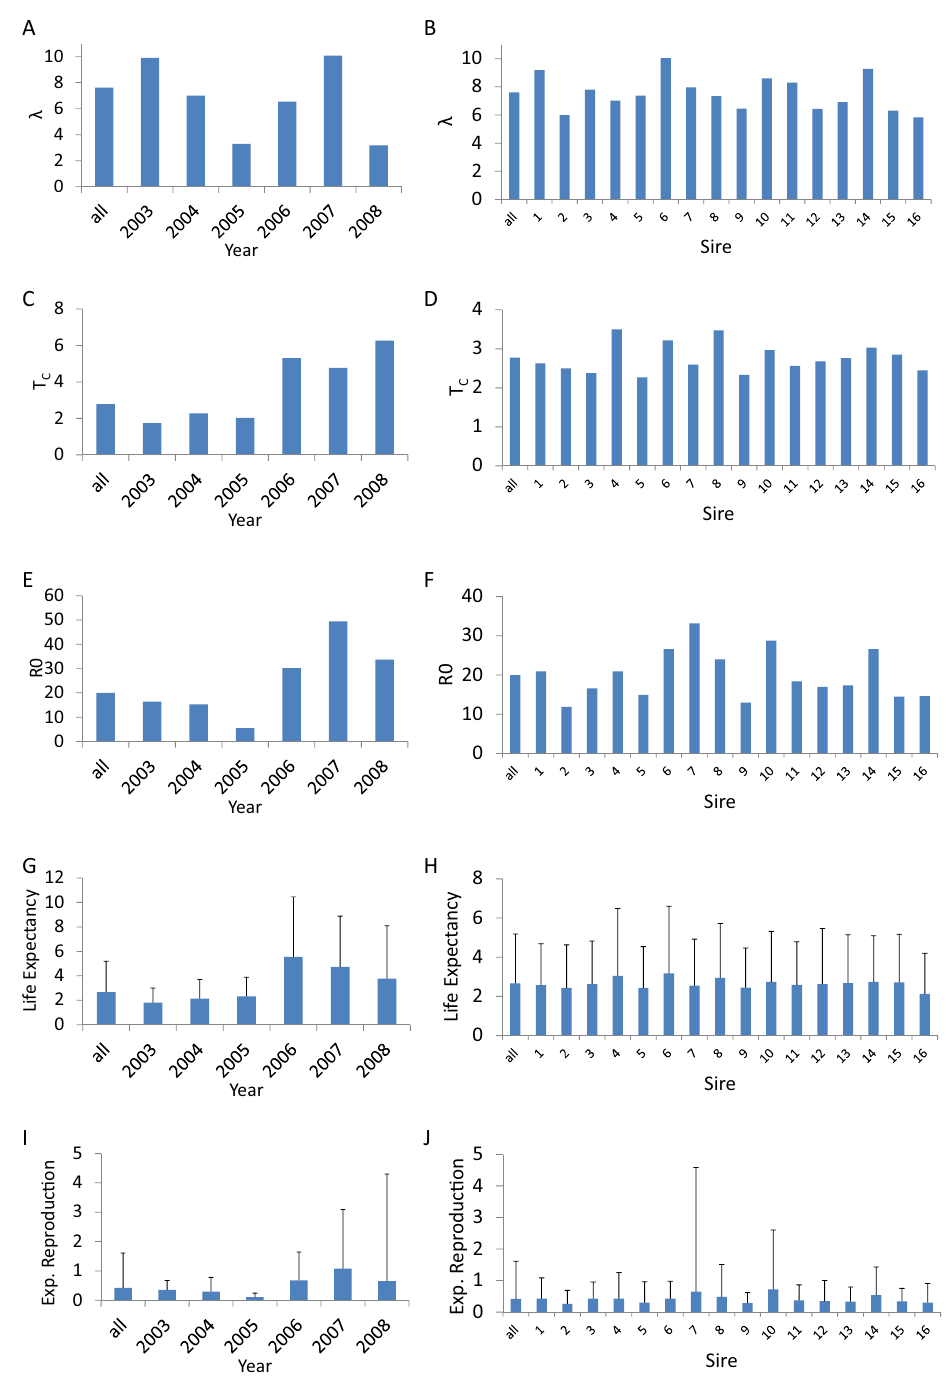
Figure 1. Differences in population growth rate λ ( A , B ), cohort generation time T C ( C , D ), net reproductive rate R 0 [expected number of seedlings recruited] ( E , F ), life expectancy ( G , H ), and expected reproduction [expected number of inflorescences] ( I , J ) among years ( A , C , E , G , I ) and sires ( B , D , F , H , J ). The most left bar depicts the value across all years or sires, weighted by the individuals within each year-sire combination. For life expectancy and reproduction ( G , H , I , J ) we plotted the mean + Stdev. This standard deviation comes from unexplained variability in size within years and sires that is not related to either reproduction or survival, we argue here that this variability is largely due to non-selective variation among individuals sharing the same sire and environment (year). See also Table 2, Appendix S1 10,21